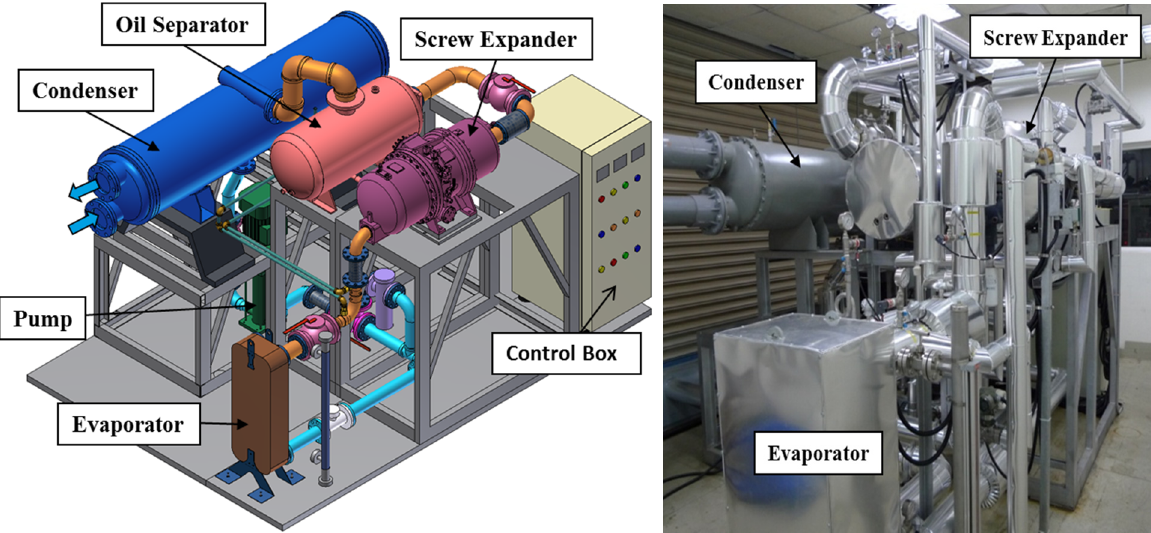
Figure 3. Three-dimensional layout ( left ) and photograph ( right ) of the ORC